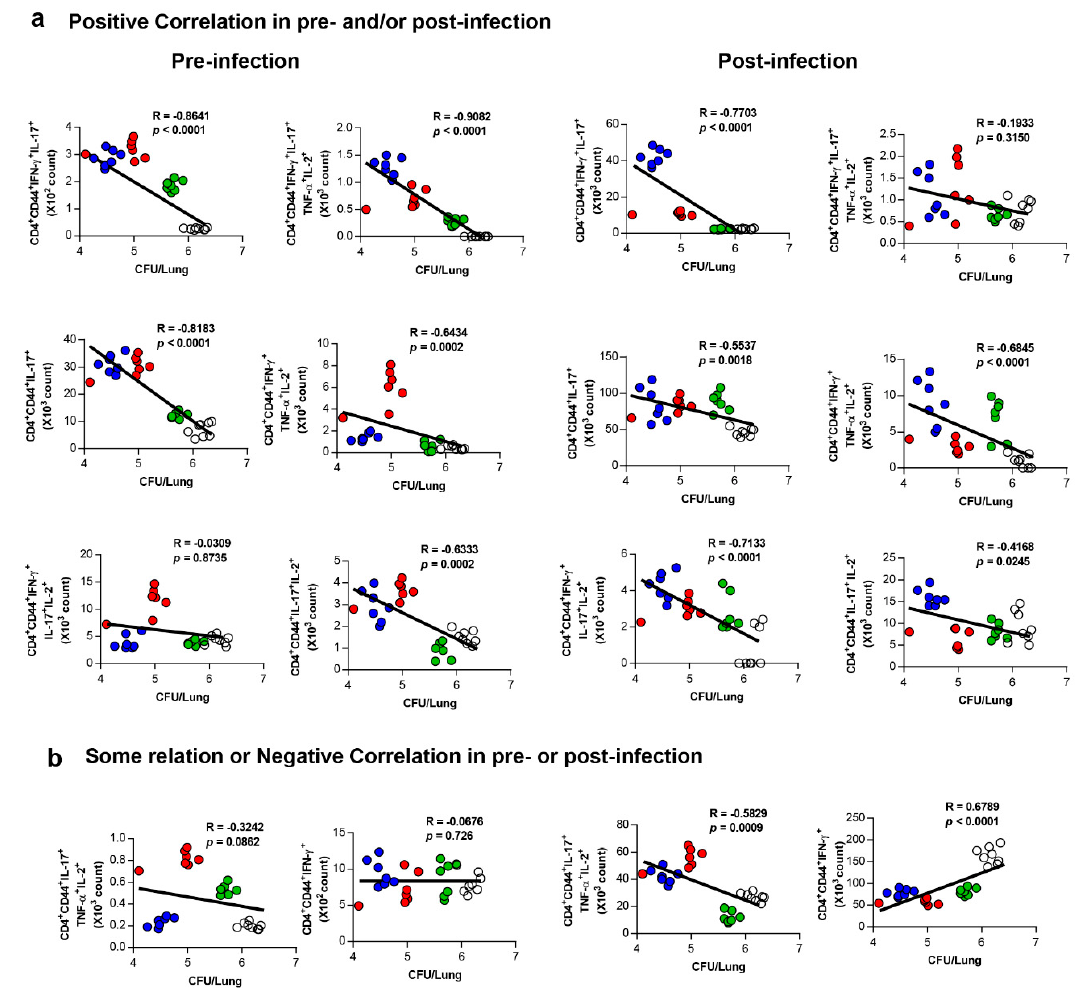
Figure 5. Analysis of protective correlations for protection level with vaccine-induced immune responses pre- and post-infection. Relationship between protection (CFU) and ESAT-6 specific CD4 + CD44 + IFN- γ + , CD4 + CD44 + IFN- γ + IL-17 + TNF- α + IL-2 + , CD4 + CD44 + IFN- γ + IL-17 + IL-2 + , CD4 + CD44 + TNF- α + producing T-cells or CD4 + CD44 + IFN- γ + IL-17 + is shown as a fitted regression line with the correlation coefficient. ( a ) Positive correlation, ( b ) some relation or negative correlation. Spearman’s r and P values of the correlations are indicated. White circle: naïve or infection, green circle: BCG, red circle: BCG+E6, and blue circle: BCG+HSP90-E6.